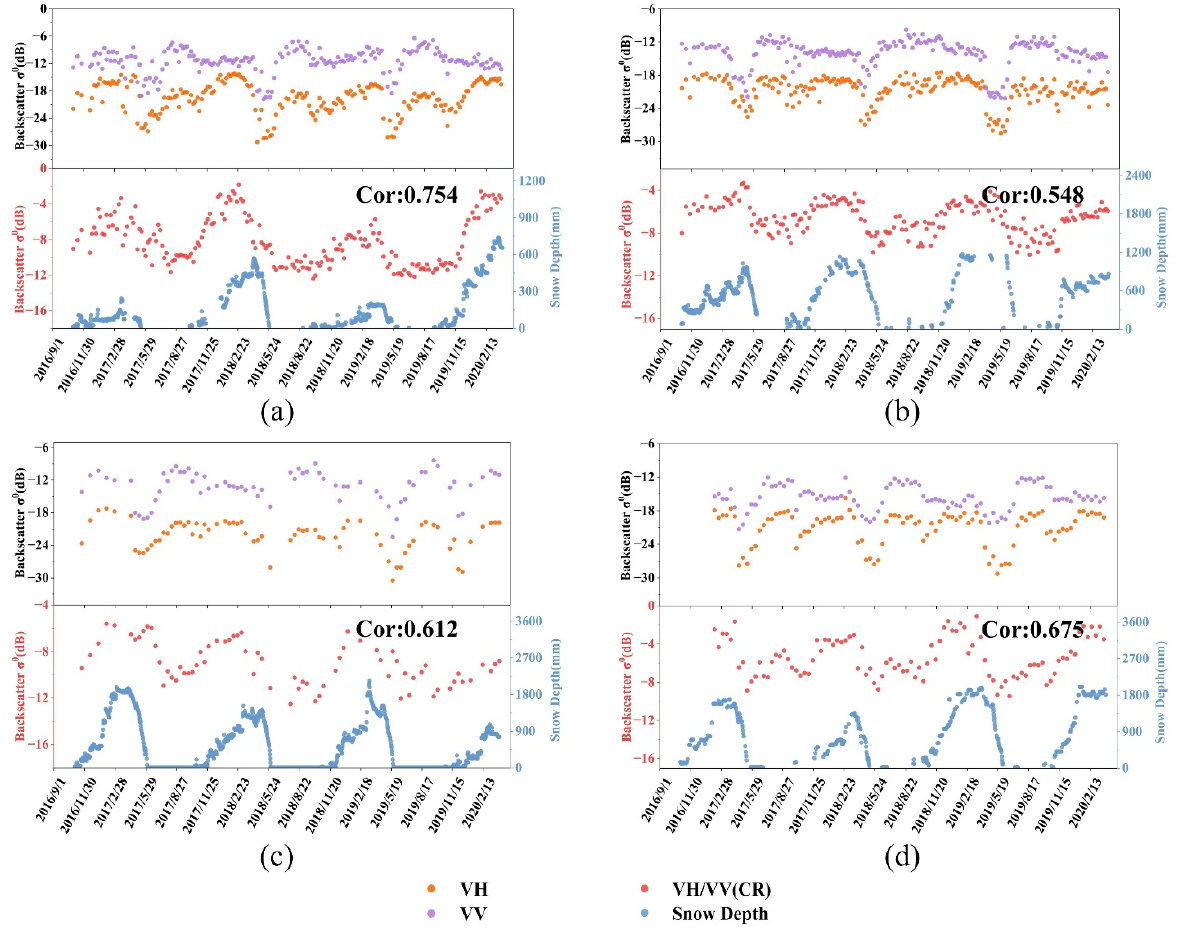
Figure 4. Comparison of daily VH, VV and VH/VV(CR) values with SD provided by the meteorological station: ( a ) FV; ( b ) RS; ( c ) NK; ( d ) AP. Backscatter values from the same orbit of Sentinel-1 ascending data. Some outliers in the data were removed.